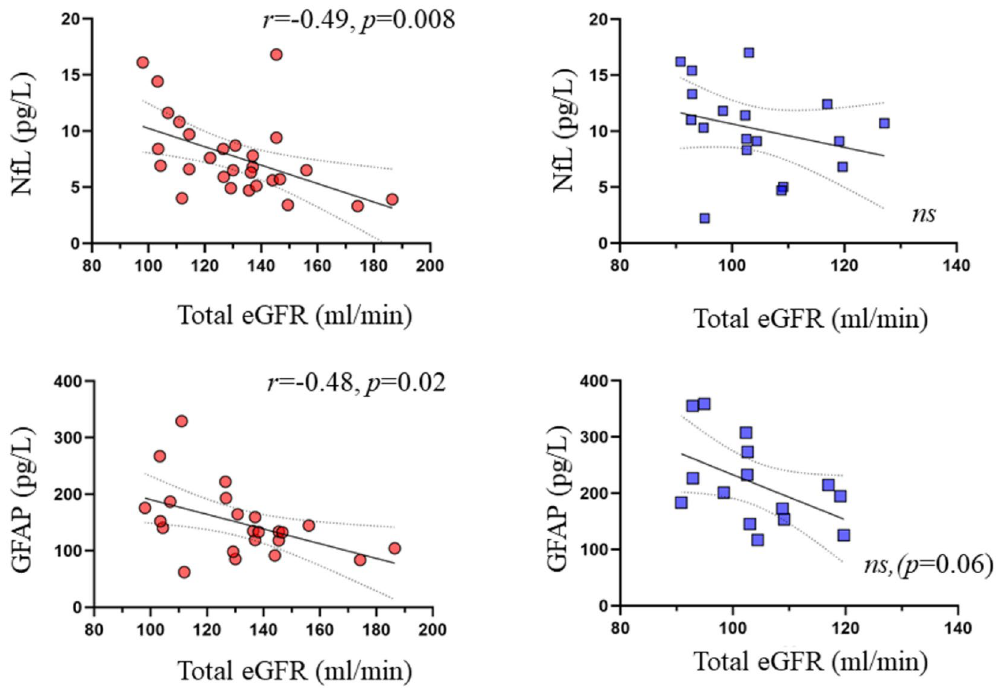
Figure 2. The correlation between NfL and GFAP with total eGFR was driven by the obese subjects. Red circles: subjects with obesity; blue squares: lean